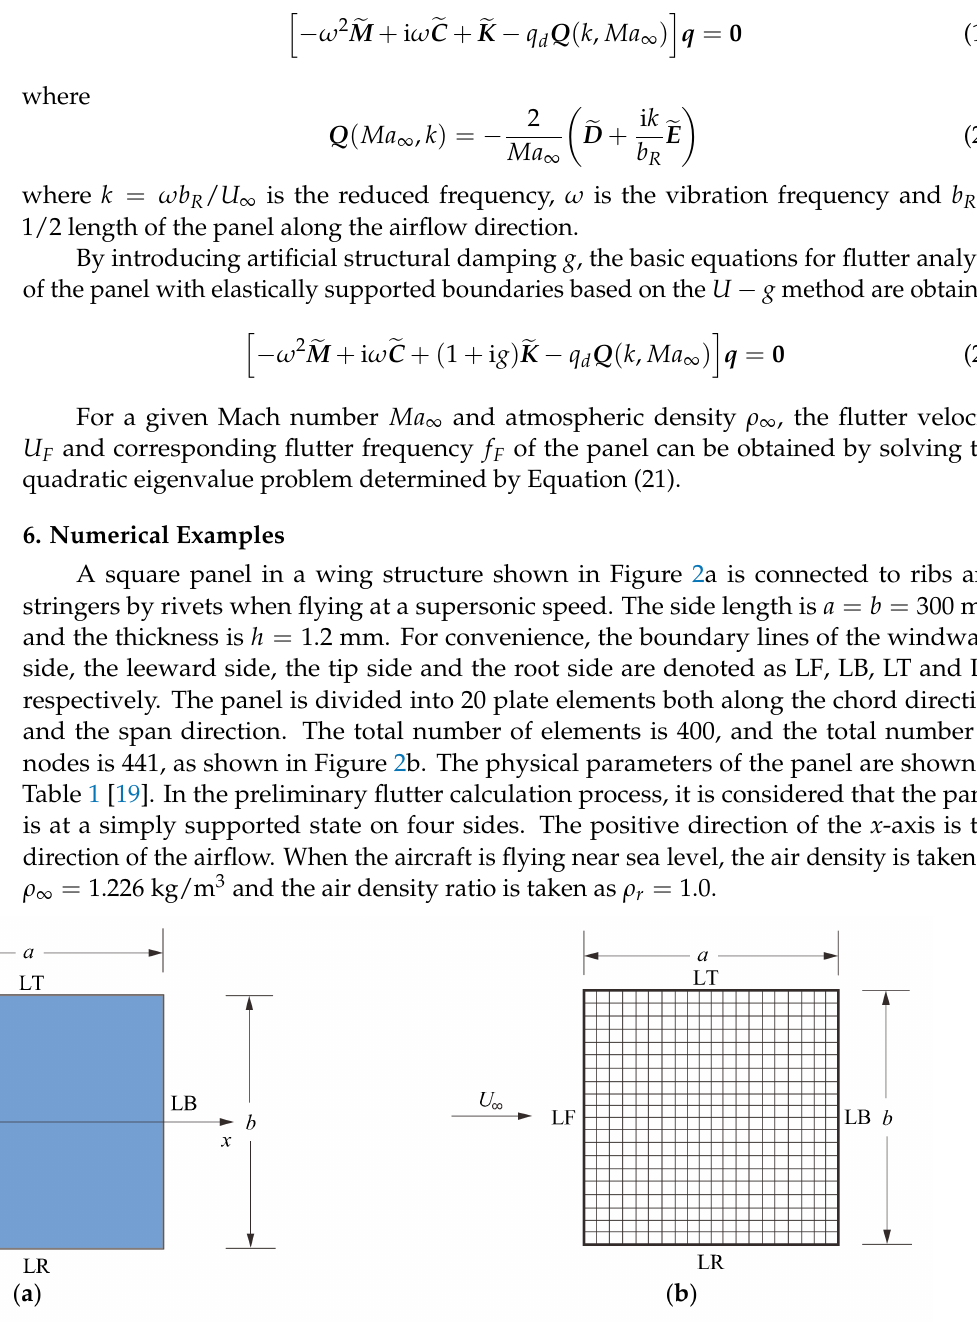
Figure 2. A square panel with simply supported boundaries on four sides: ( a ) geometric model; ( b ) finite element